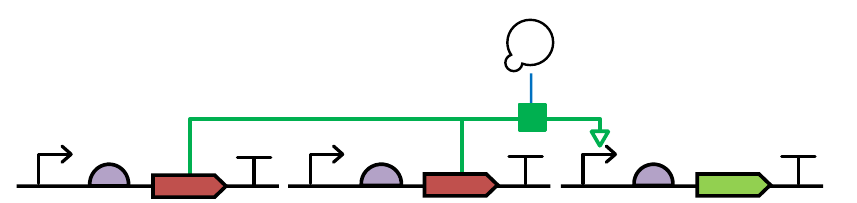
Figure 37: Phosphorylation of an inactive transcription factor (produced by two different CDSs) by a kinase to form an active transcriptional activator, which then stimulates a